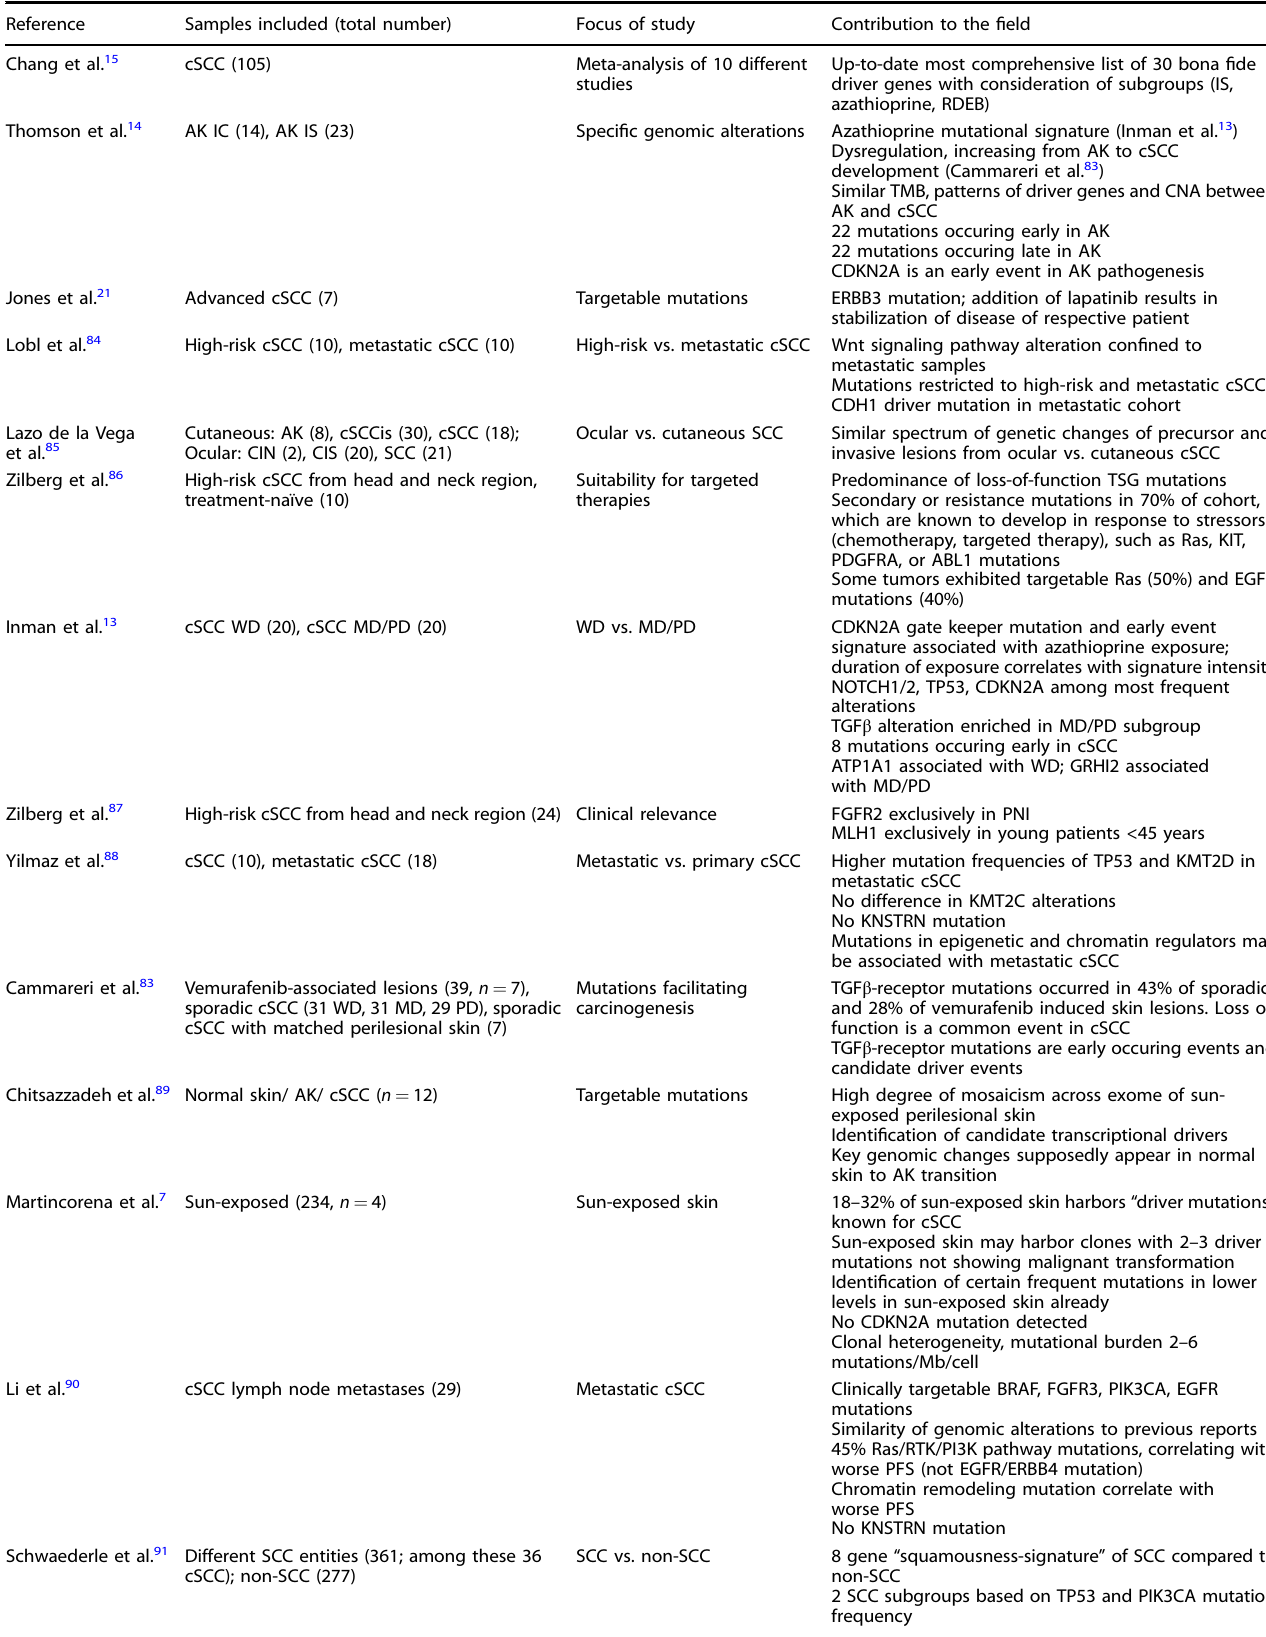
Table 1. Reports on somatic mutational landscape in human cSCC